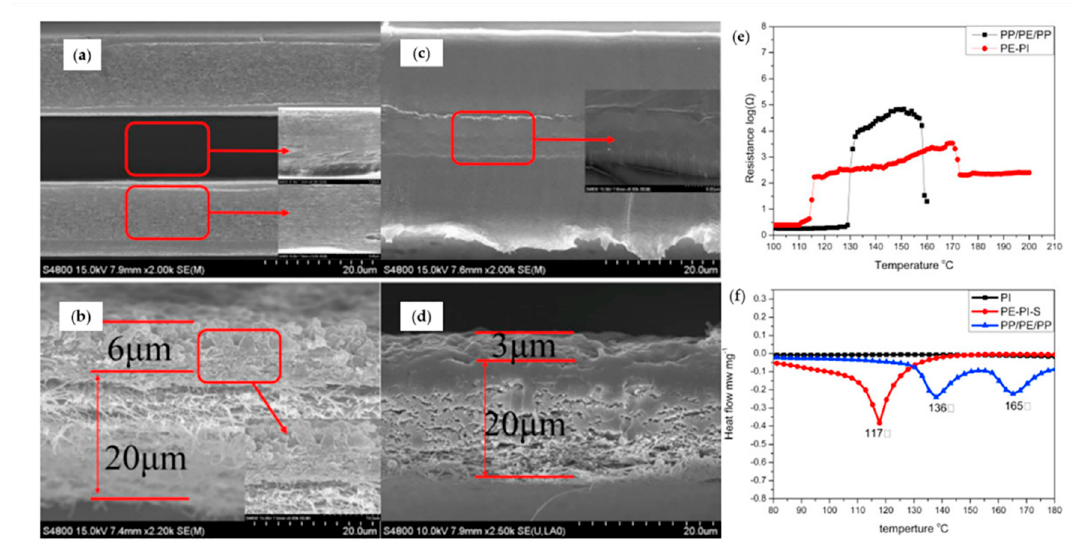
Figure 2. ( a – d ) SEM images: ( a , c ) cross-section of a PP/PE/PP separator before and after hot treatment at 140 °C for 0.5 h; ( b , d ) cross-section of a PE-PI-S nonwoven membrane before and after hot treatment 140 °C for 0.5 h. ( e ) Impedance change with a heating rate 1 °C min − 1 of the PP/PE/PP separator and PE-PI-S nonwoven membrane. ( f ) differential scanning calorimetry of the PI, PP/PE/PP, and PE/PI/S membranes [48]. Copyright (2015) Elsevier B.V.